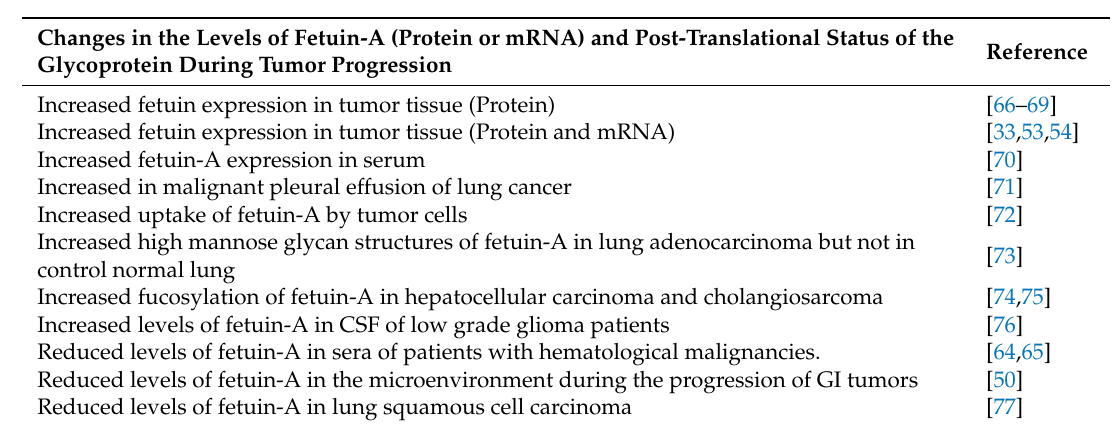
Table 1. Changes in the levels of fetuin-A (protein or messenger RNA (mRNA)) and post-translational status of the glycoprotein during tumor